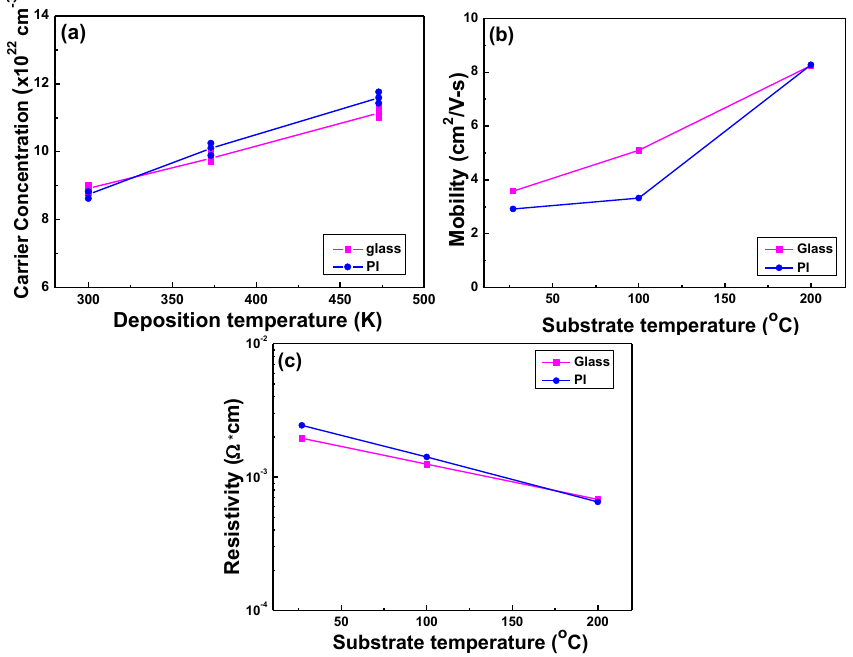
Figure 6. Variations of the ( a ) Hall mobility; ( b ) carrier concentration; and ( c ) resistivity of the GZO thin films as a function of used substrates and deposition temperature.